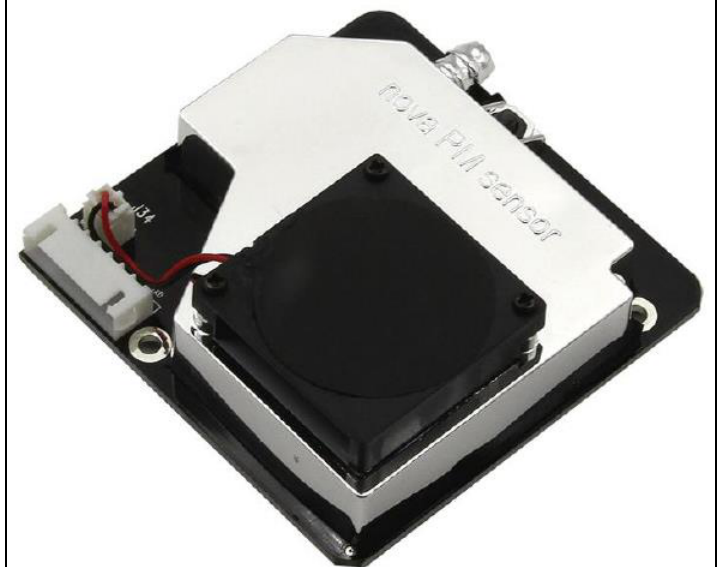
Figure 4. ( a ) Scheme of a single node, ( b ) photo of a single node.